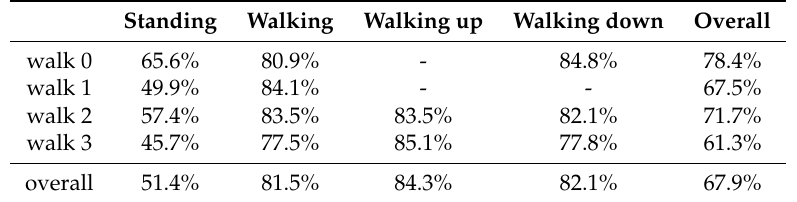
Table 2. The resulting detection rates provided by the activity recognition for all conducted walks. As the method suffers from a (time) lag, caused by the used moving average, we shifted the measured activity according to the average lag over all walks (2.96s). Some cells of the table are empty, because the respective walk did not require this